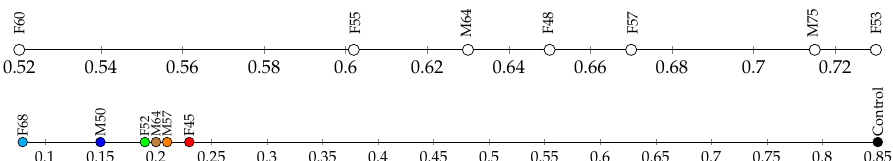
Figure 8. Comparison of the distribution of BMD values (g patients whose gender (F or M, for female or male, respectively) and age is indicated above the corresponding value; ( bottom ) average trabecular BMD of our